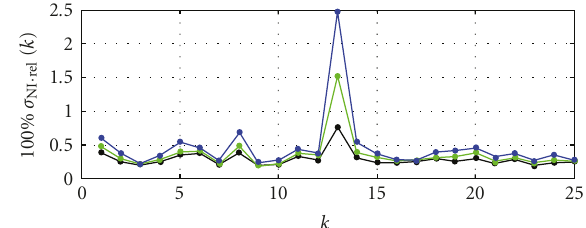
versus image n · NI · rel equal to n 0